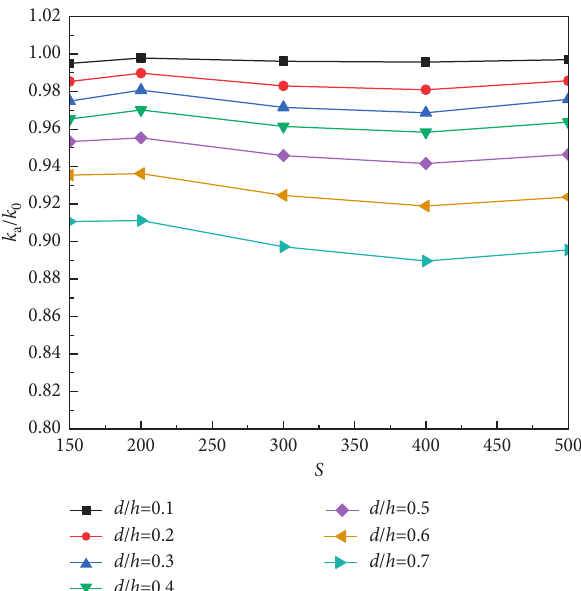
Figure 20: Distortional buckling coefficient of columns with different spacings and diameter of circular